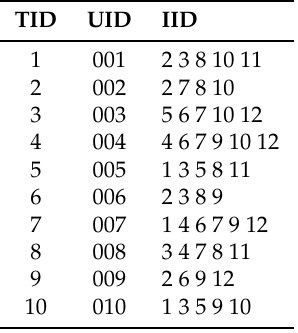
Table 1. An example of visited